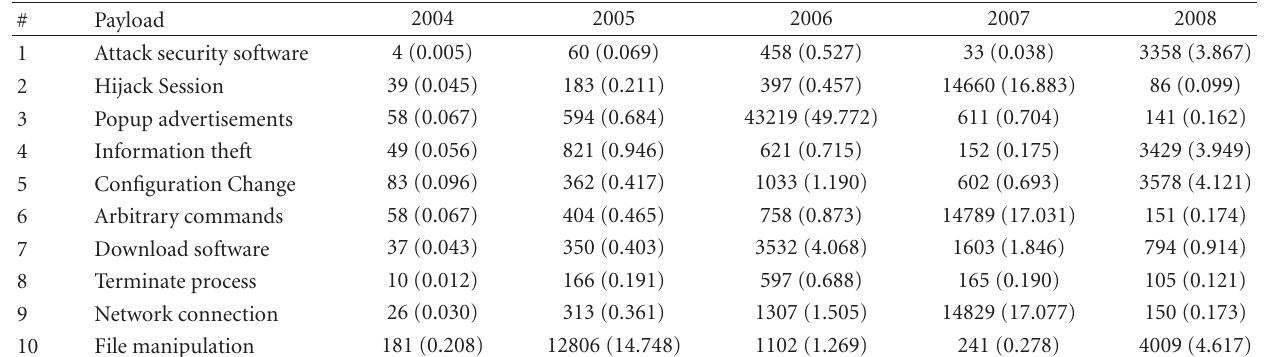
Table 7: Grayware classification based on payload and discovery date.